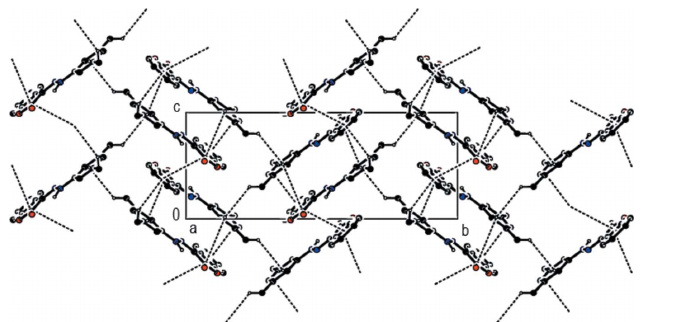
Figure 4 A packing diagram of the title compound viewed along the a -axis, showing C—H (cid:2)(cid:2)(cid:2) (cid:2) interactions (dashed lines). Only H atoms involved in the interactions and N-bound H atoms are shown for clarity.